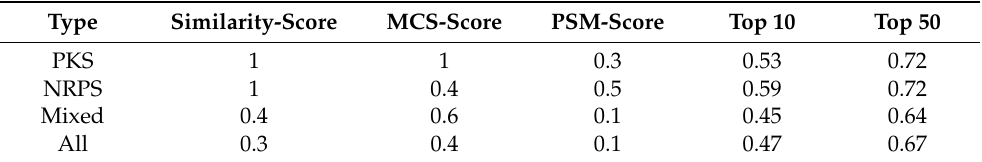
Table 10. Best scoring parameter weights for each BGC type. The corresponding percentage of Top 10 and Top 50 ranked instances of the true SMs are